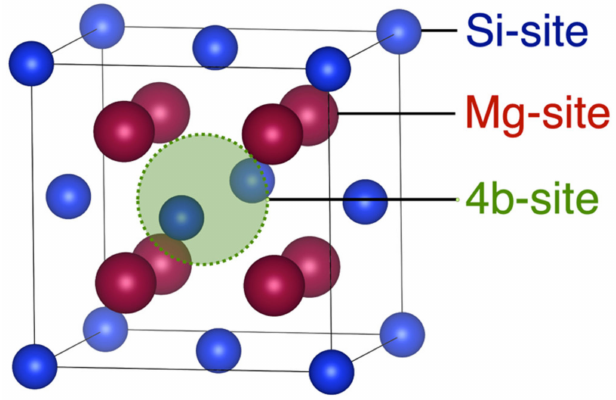
Figure 2. Part of the Mg 2 Si crystal structure showing Mg-, Si-, and